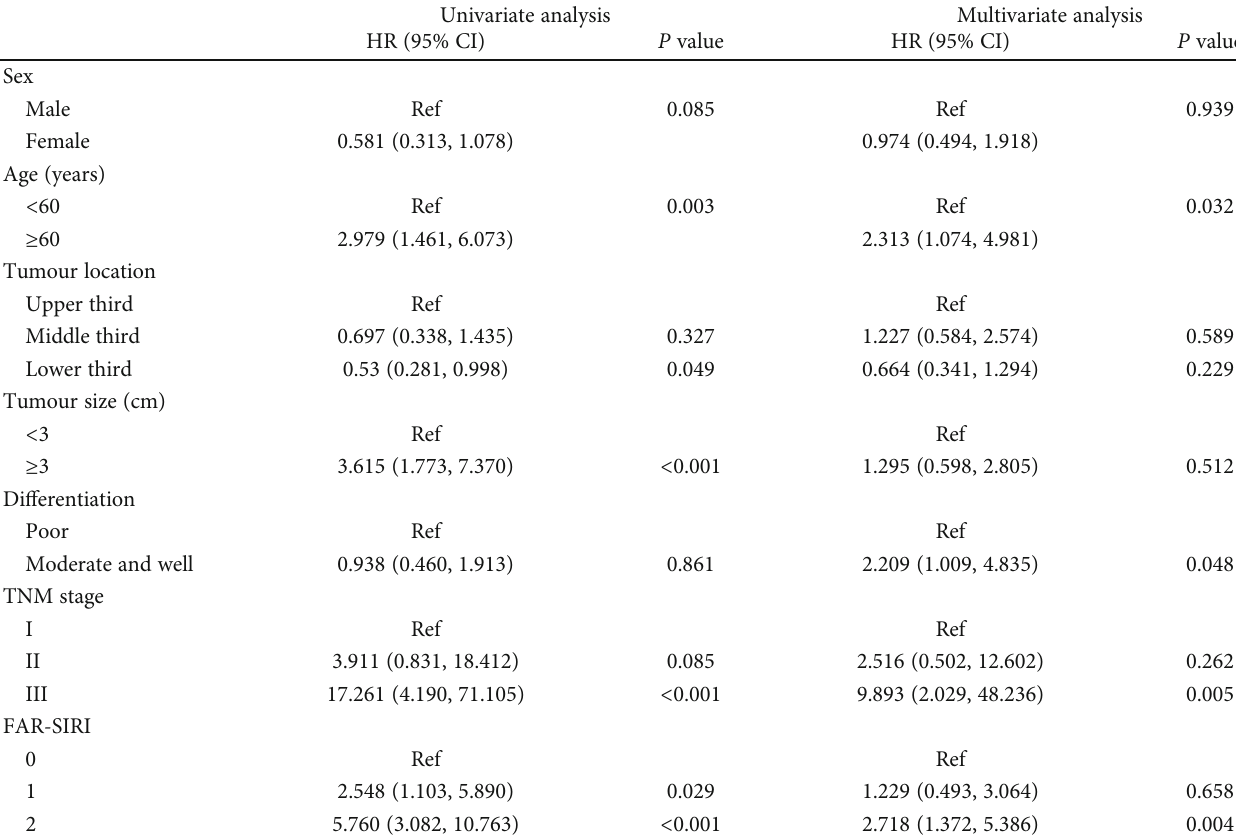
Table 3: Univariate and multivariate analysis of OS clinicopathologic variables in relation to OS in resectable gastric cancer patients. Univariate